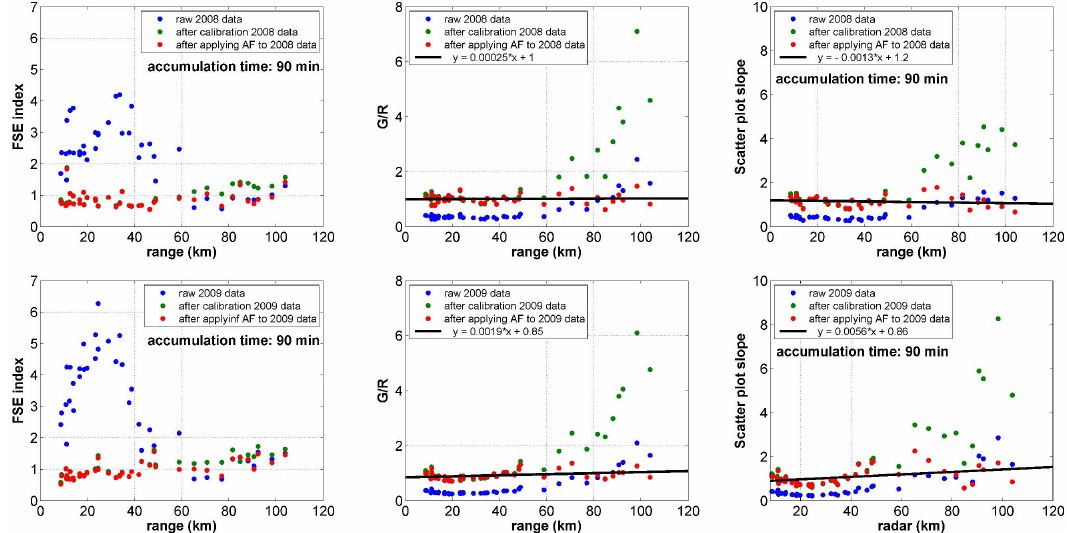
Fig. 17. FSE index, G/R ratio and slope of the scatter plots’ regression lines’ trends with distance (left, middle and right panels, respectively) of rainfall time series pairs obtained during 2008 (upper panels) and 2009 (lower panels) by Polar 55C and by each rain gauge, for the initial data sets (dots in blue), after calibration (dots in green) and after adding the AF (dots in red). Black lines are best fitting lines referring to red dots. Accumulation time is 90